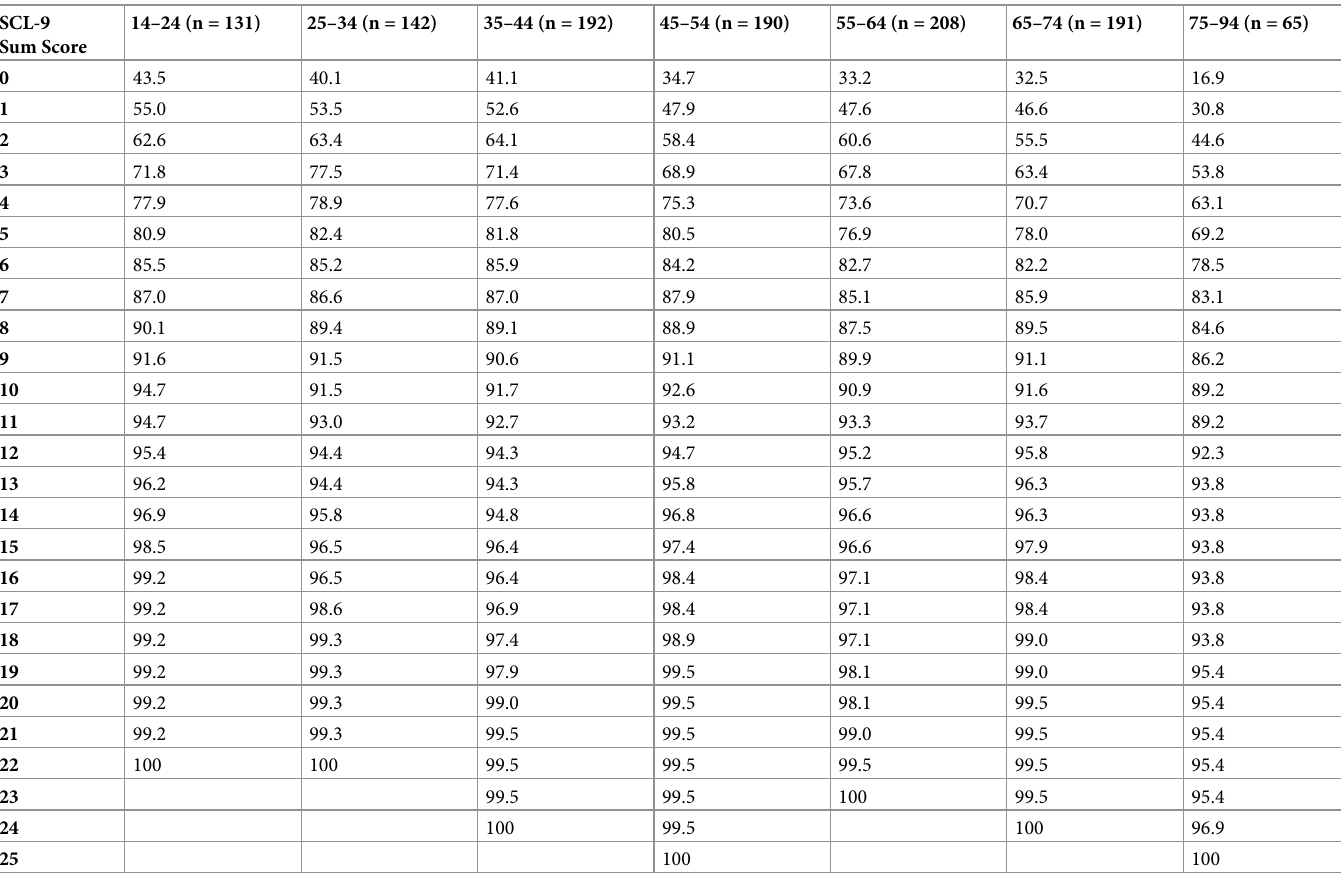
Table 5. Normative percentile values: Males. SCL-9 Sum Score